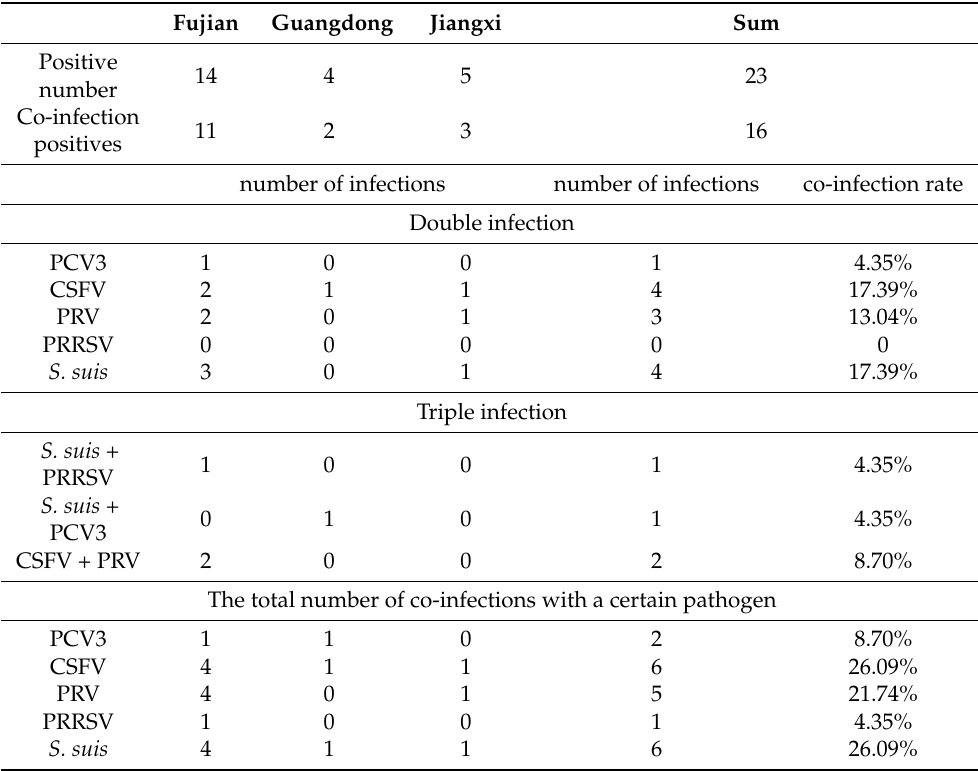
Table 1. Co-infection of PCV2-positive samples with other porcine-associated pathogens.